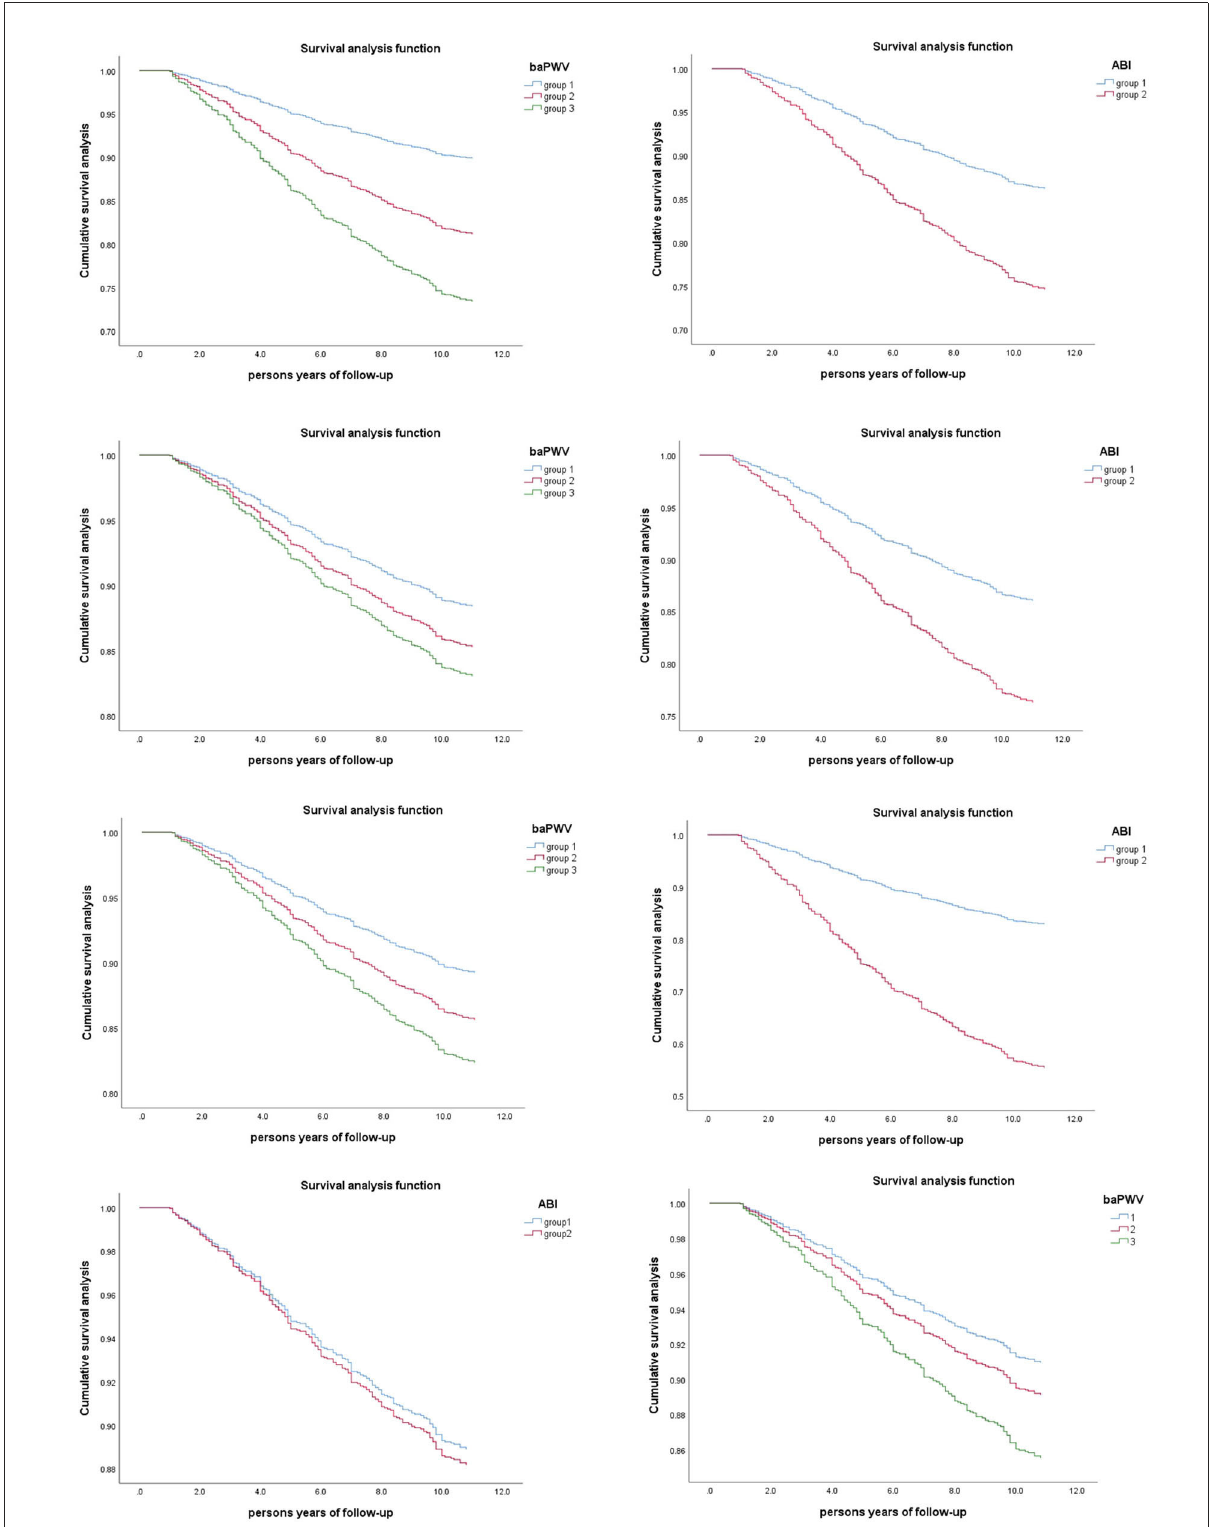
FIGURE5 Survival analysis curves were drawn for the four models of ABI and baPWV in the Cox proportional risk